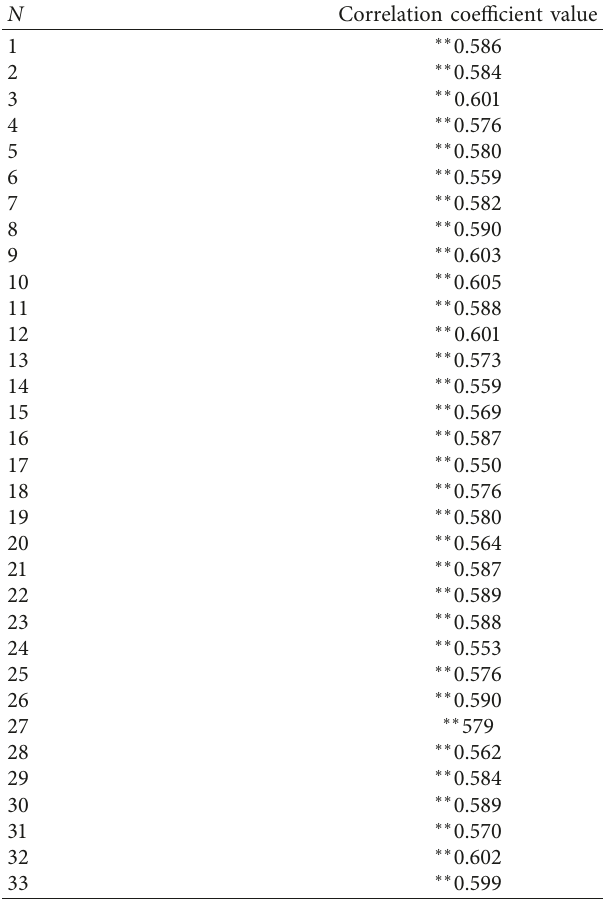
the psychological resilience scale and the overall score of the scale. N Correlation coefficient